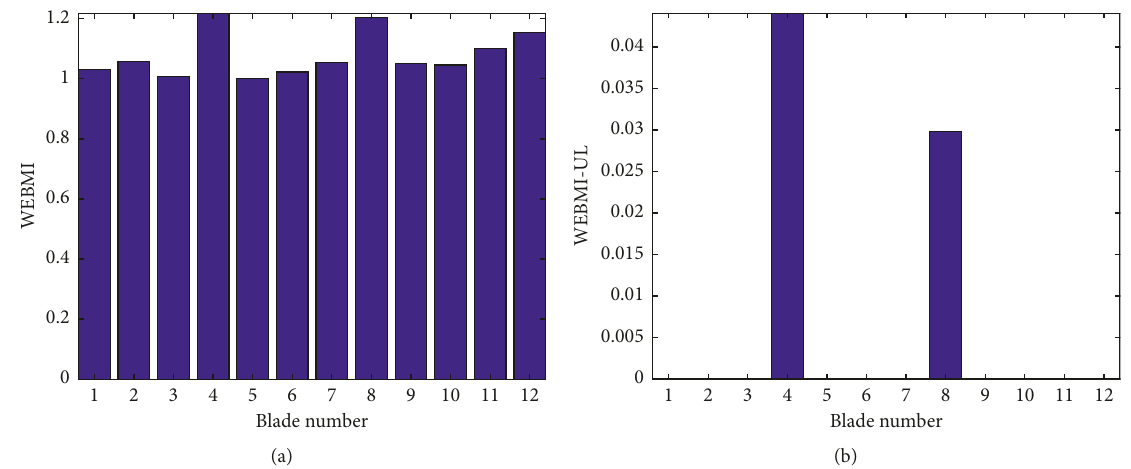
Figure 21: Optical sensor results for the added mass located at blades 4 and 8. (a) WEBMI and (b)